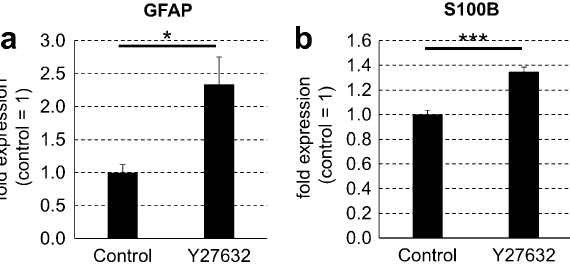
Figure 5. Treatment with ROCK inhibitor increases mRNA expression of astrocyte markers after 3 days of differentiation of mouse embryonic neural stem cells in the absence of serum. ( a ) Mouse embryonic NSCs were cultured on commonly used plastic plates for 3 days without (control) or with 10 μM Y27632 (Y27632) in serum-free condition. mRNA expression of GFAP, S100B and GAPDH on each plate type was detected by qPCR analysis. The expression levels of ( a ) GFAP and ( b ) S100B were normalized relative to that of GAPDH. Error bars represent the standard deviation; * p < 0.05, *** p < 0.005 (Student’s t test). ROCK Rho-associated